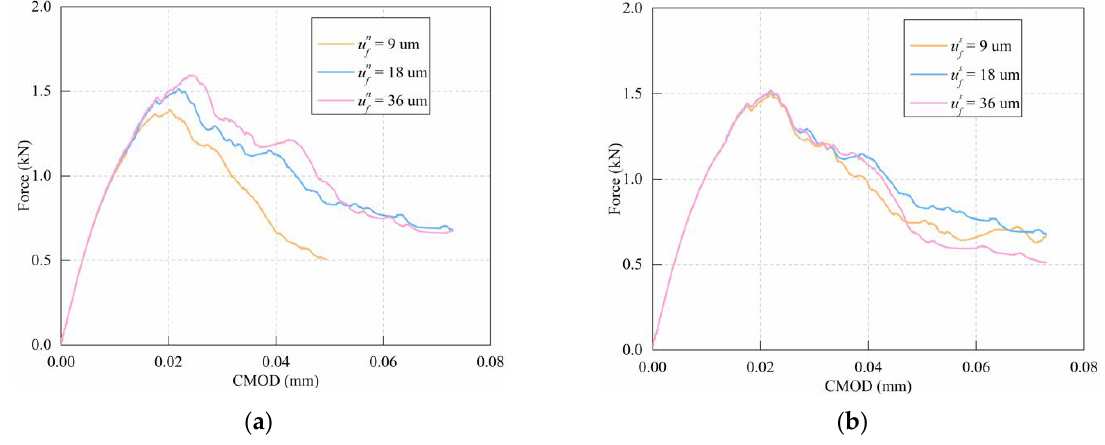
Figure 15. Effect of softening parameter: ( a ) normal softening parameter; ( b ) shear softening param-